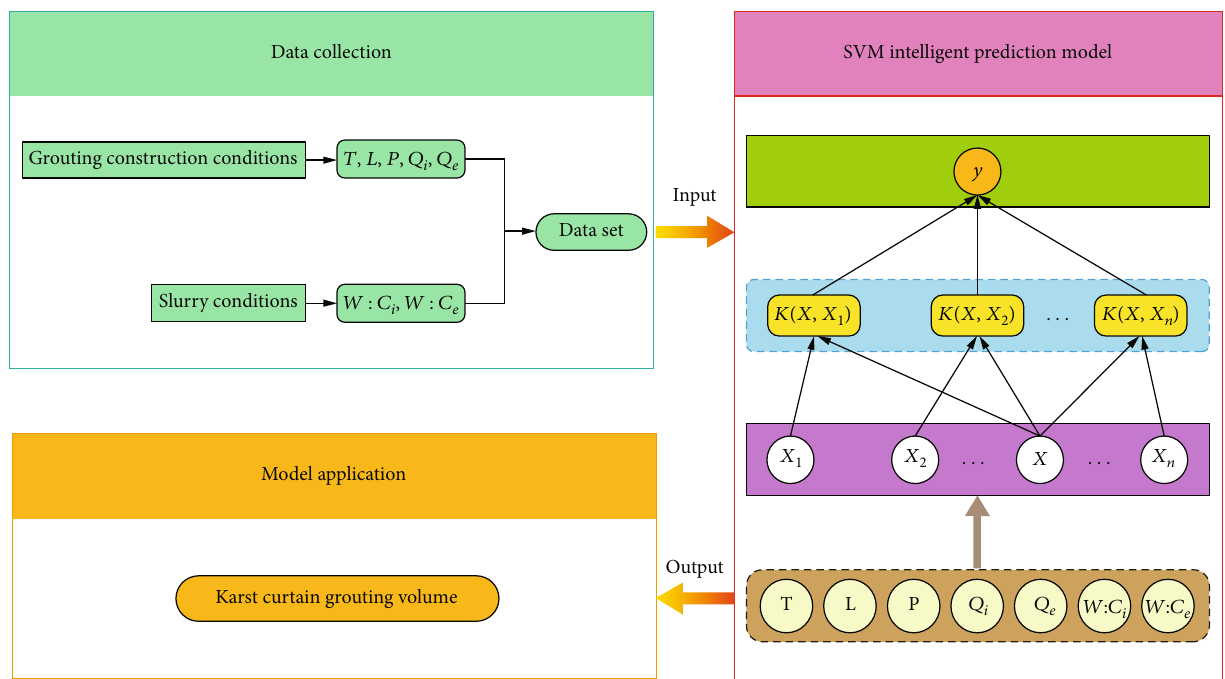
Figure 2: The prediction method of the KCGV based on